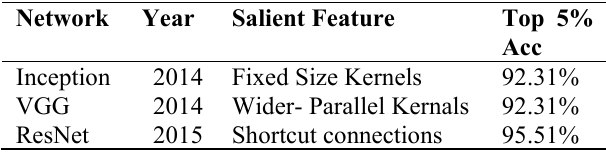
Table 2. Comparison of Deep Learning Models [25]